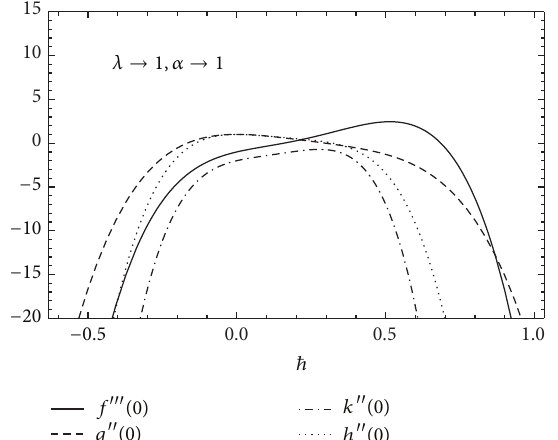
Figure 5: The influence of the couple stress parameter 𝜆 on 𝑓 󸀠 (𝜂) for 𝛼 = 1 , ℏ = −0.2 , and 𝜆 = 0 (Newtonian case).